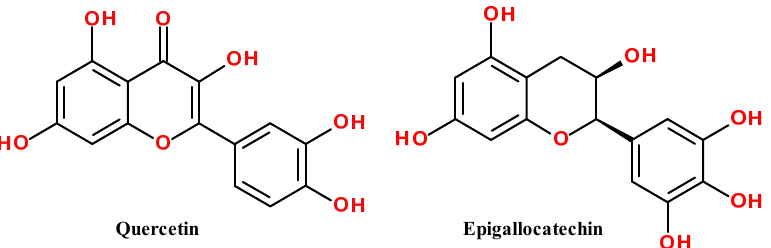
Figure 5. Some natural inhibitors for β -glucosidase—quercetin and epigallocatechin ( EGC ). Het- eroatoms and key functional groups are color-coded.